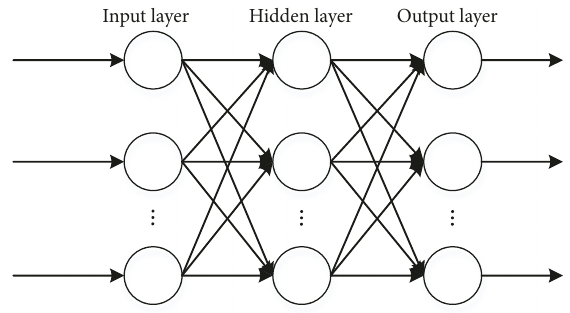
Figure 19: BP neural network structure.